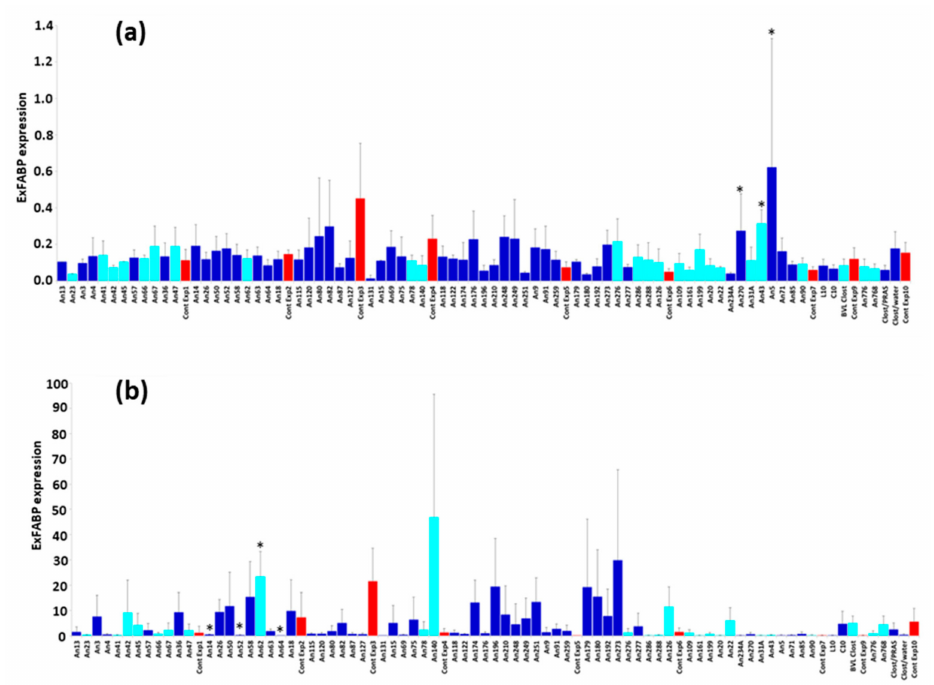
Figure 2. Extracellular fatty acid binding protein (ExFABP) expression in the caecum of inoculated and challenged chickens. ( a ) ExFABP expression in the caecum of 8-day-old chicks inoculated with di ff erent anaerobes on day 1 of life. Groups of chicks were inoculated on the day of hatching, and seven days later, expression of ExFABP was determined in the caecum of inoculated chicks by quantitative RT-PCR. Light-blue columns: ExFABP expression in the chicks that were successfully colonised by indicated gut anaerobes. Dark blue columns: ExFABP expression in the chicks that were inoculated with anaerobes that did not colonise the chicken caecum. Red columns highlight ExFABP expression in control chicks included in each experiment batch (except for the experiment with L10 and C10 mixtures in which no noninoculated chicks were included). *—Significantly di ff erent expression from appropriate control (Cont Exp7) by Kruskal–Wallis test followed by Dunn’s post hoc test ( p < 0.05). ( b ) ExFABP expression in the caecum of 12-day-old chicks inoculated with di ff erent anaerobes on day 1 of life and infected with S. Enteritidis on day 8. If the isolate used for inoculation on day 1 exhibited a protective e ff ect, lower expression was expected in the colonised chicks compared to the controls. Light-blue columns: ExFABP expression in the chicks that were successfully colonised by the tested isolate. Dark blue columns: ExFABP expression in the chicks that were inoculated by isolates that did not colonise the chicken caecum. Red columns: ExFABP expression in noninoculated control chicks included in each experiment batch (except for the experiment with L10 and C10 mixtures in which no noninoculated control chicks were included). *—Significantly di ff erent expression from the appropriate control (Cont Exp2) by Kruskal–Wallis test followed by Dunn’s post hoc test ( p <